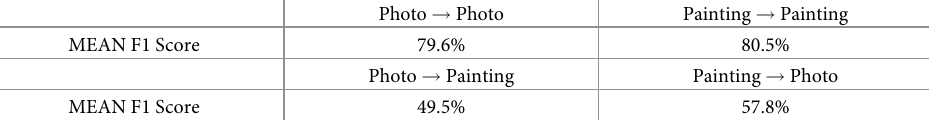
Table 4. Classifier performance across domains. Classifiers are trained to distinguish cotton/wool from silk/satin. The first column represents the classifier trained on photographs, and the second column represents the classifier trained on paintings. In the first row, the classifiers are tested on images of the same type they were trained on (i.e., trained and tested on photos, and trained and tested on paintings). In the second row, the classifiers are tested on the other medium, i.e., trained on photos and tested on paintings and vice